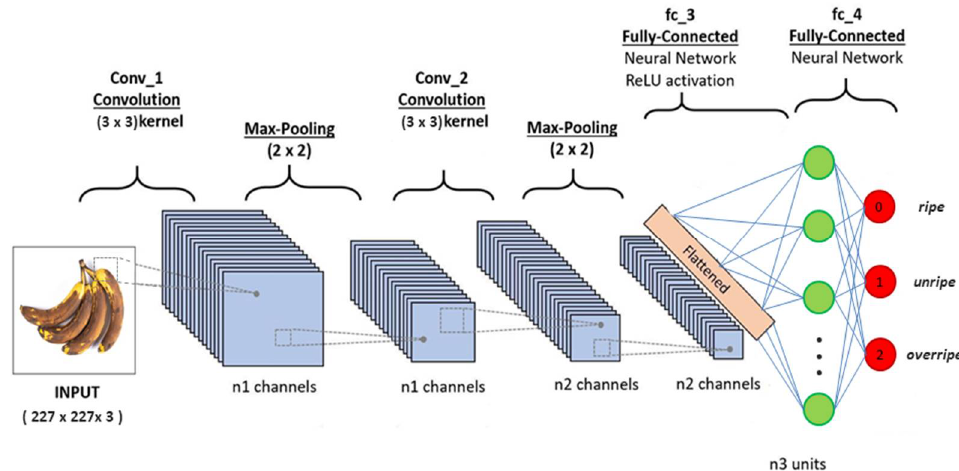
Figure 1. Basic fruit maturity classification CNN model.